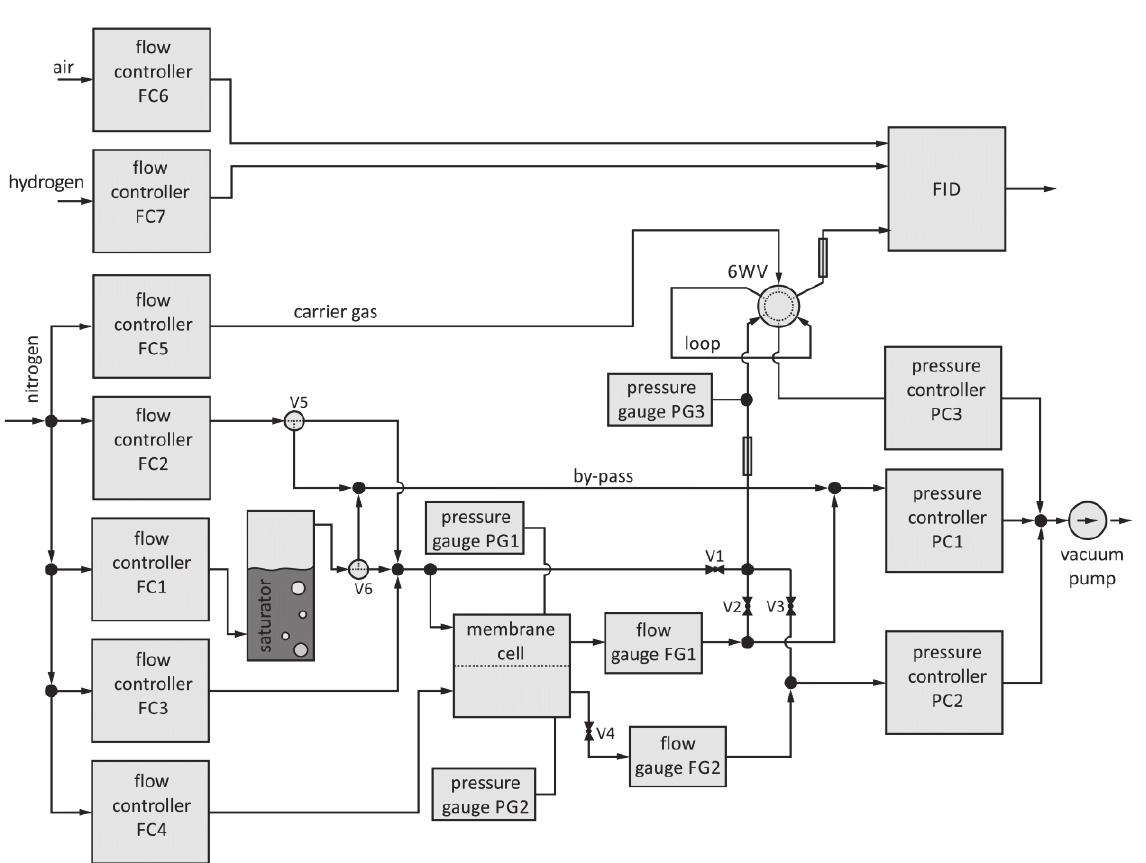
Fig. 1 – Scheme of the apparatus for vapour permeation experiments: FC – flow controller, FG – flow gauge, PC – back pressure controller, PG – pressure gauge, 100 mL cylindrical vessel for nitrogen sweep before the six-port valve for FID detector, V – 2-way or 3-way valve, 6WV – 6-way valve, FID – Flame Ionisation Detector, loop – 2920 μL in-line sample loop; operating ranges of all FC, FG, PC, and PG are summarized in Table